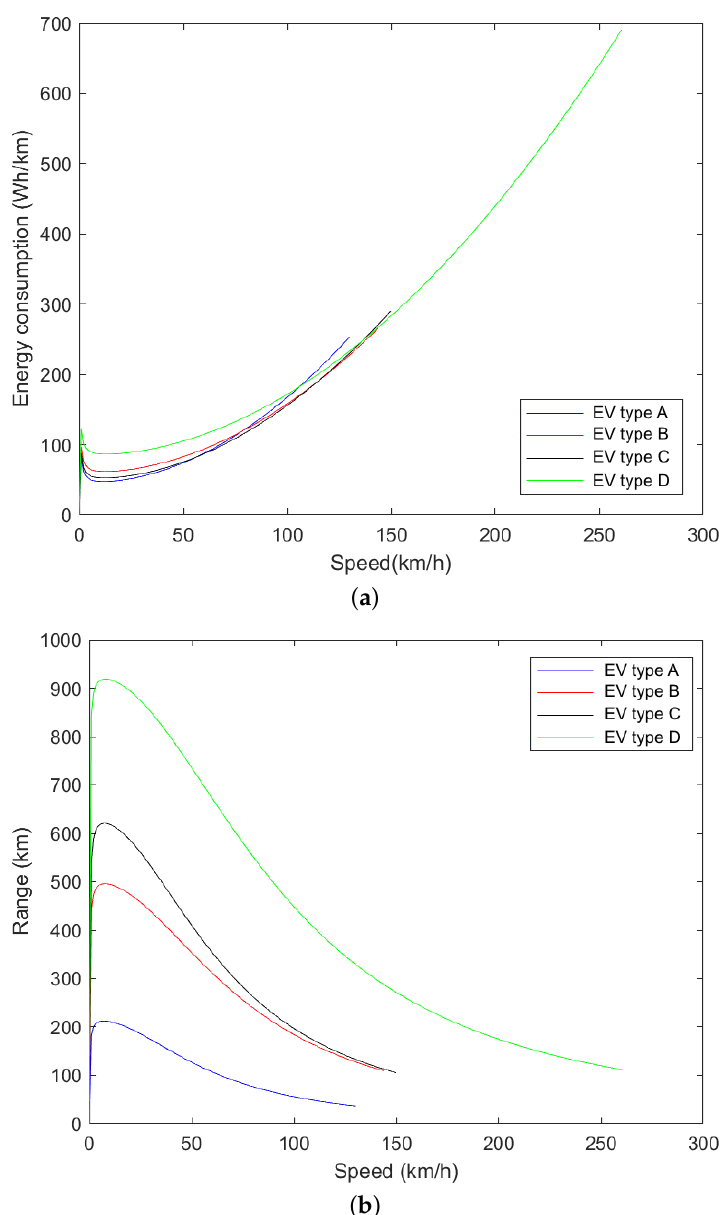
Figure 10. Energy consumption ( a ) and range ( b ) at constant